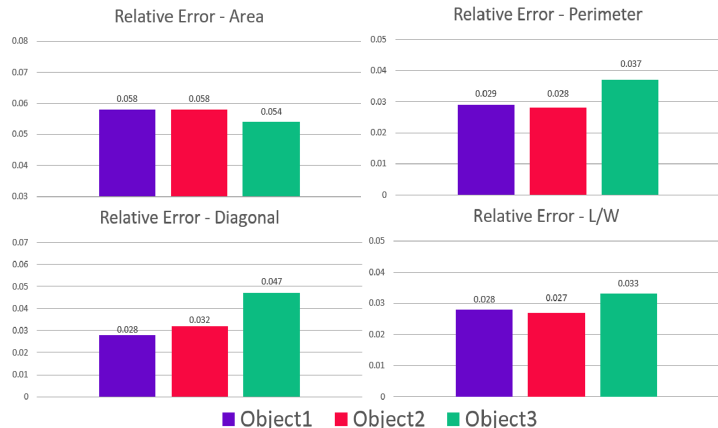
Figure 9. Absolute error for each of the measurements tested by the proposed heuristic calibration